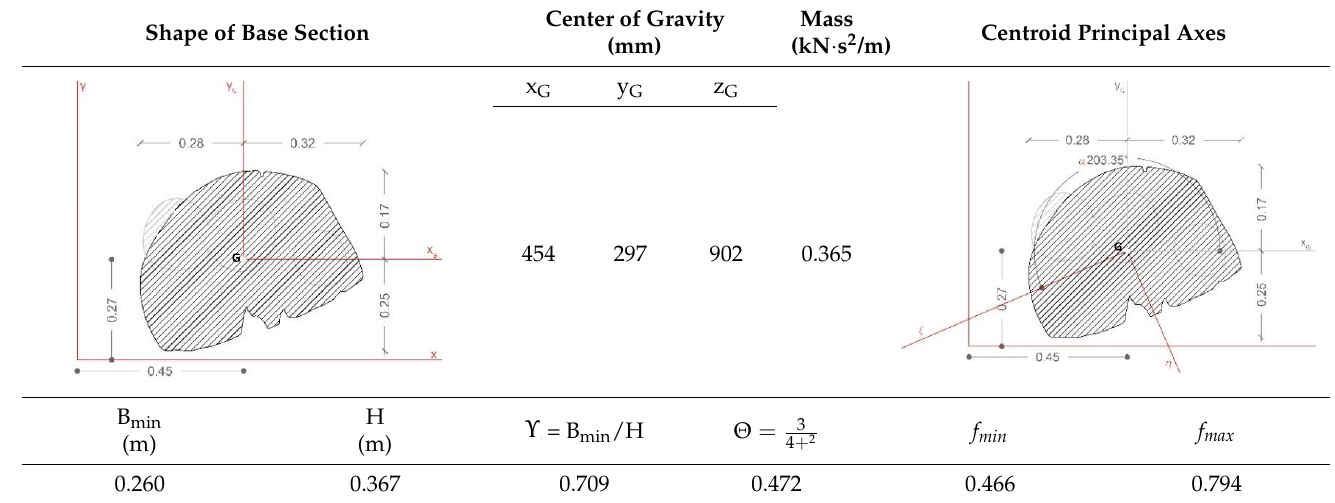
Table 5. Summary of the key characteristics of the assets for seismic rigid block.